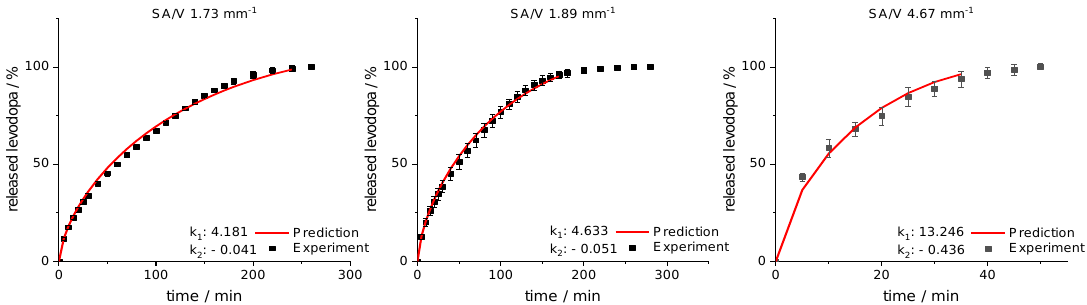
Figure 10. Predicted levodopa release vs. experimental levodopa release for SA/V ratios of 1.73 mm − 1 , 1.89 mm − 1 and 4.67 mm − 1 of the EVA-LD formulation.